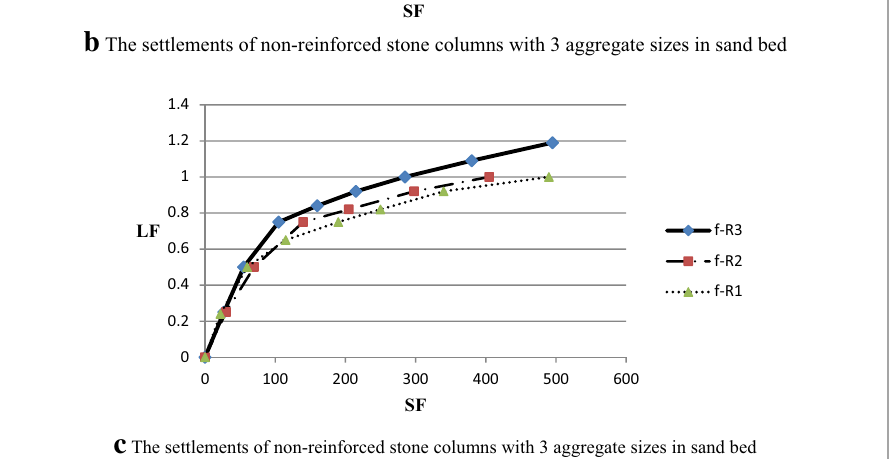
Fig. 9 Test results in sand bed for different aggregate materials and length of